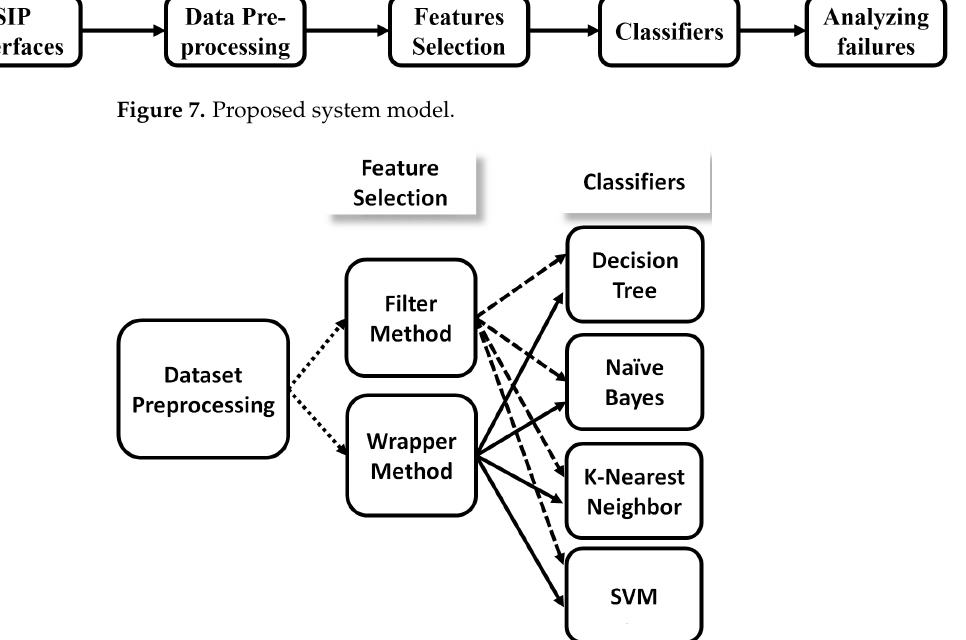
Figure 8. Proposed machine learning